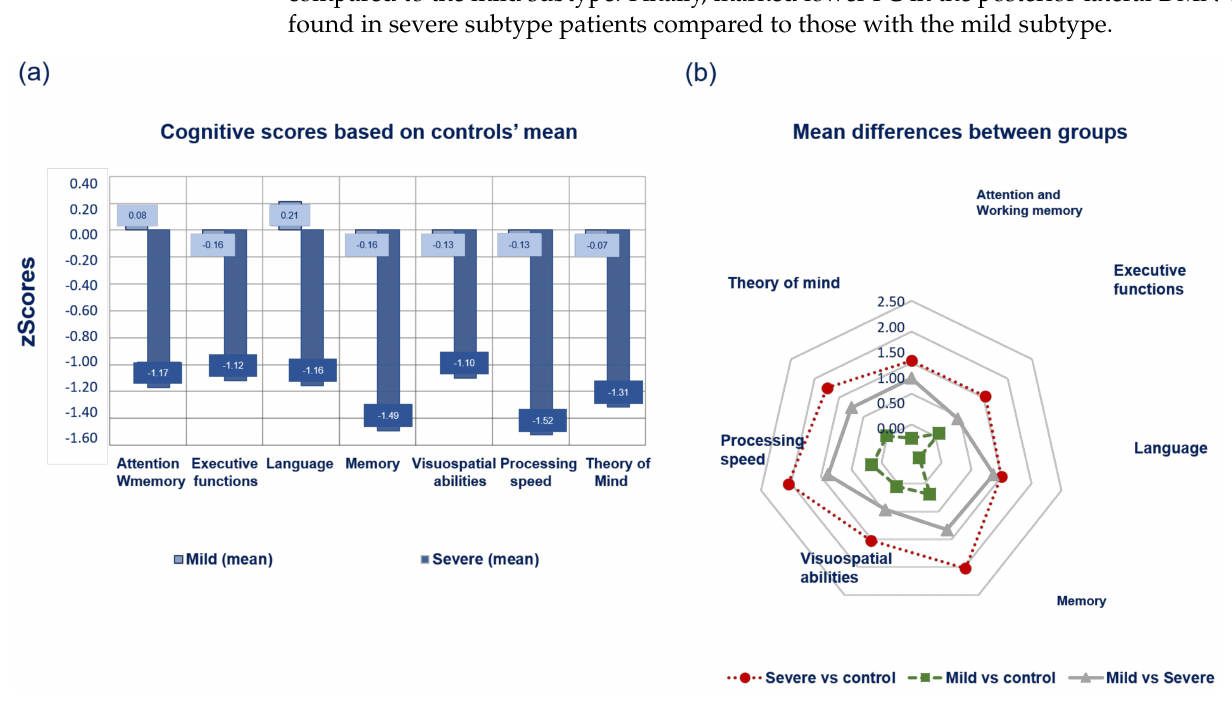
Figure 3. Cognitive profile of subtypes. ( a ) Means of cognitive domains of patients compared to controls (z = 0 is the baseline according to the mean of controls). Data are presented as z scores, and in all cases, lower z scores indicate worse performance. ( b ) Mean differences of ANOVA post-hoc analysis of the sample between subtypes and controls. Data are presented as z scores, and in all cases, lower z scores indicate less prominent differences between groups.